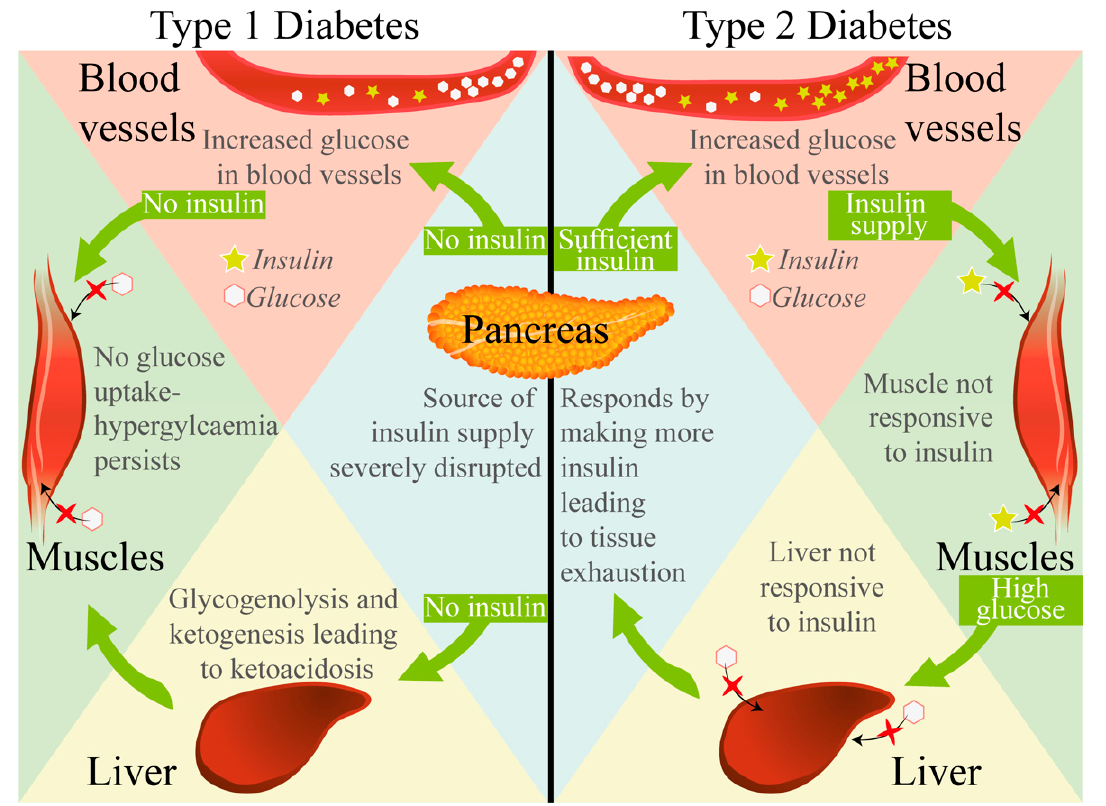
Figure 1. Biological differences between T1D and T2D. The differences in glucose uptake and insulin release between T1D and T2D are demonstrated in terms of the pancreas, blood vessels, muscle, and liver.